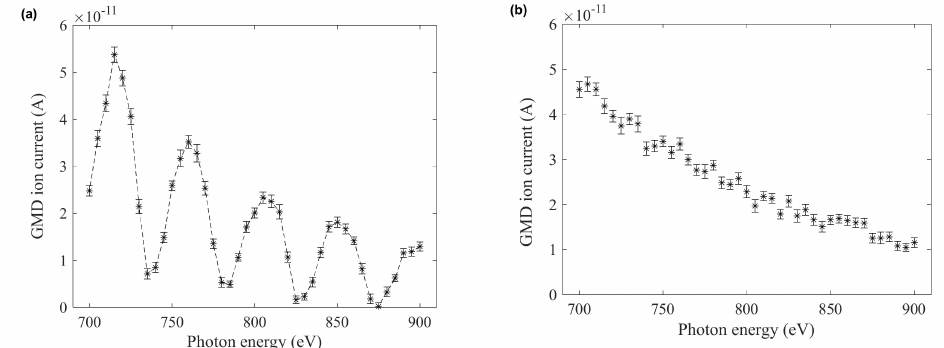
Figure 8. FEL intensity measured with a GMD ( a ) with the phase-shifter gap unchanged and ( b ) with the phase shifter gap varied according to the phase-shifter gap control line of Figure 7b. The GMD ion current shows a lower value at higher photon energy because of decreased photoionization cross-sections of gas molecules.